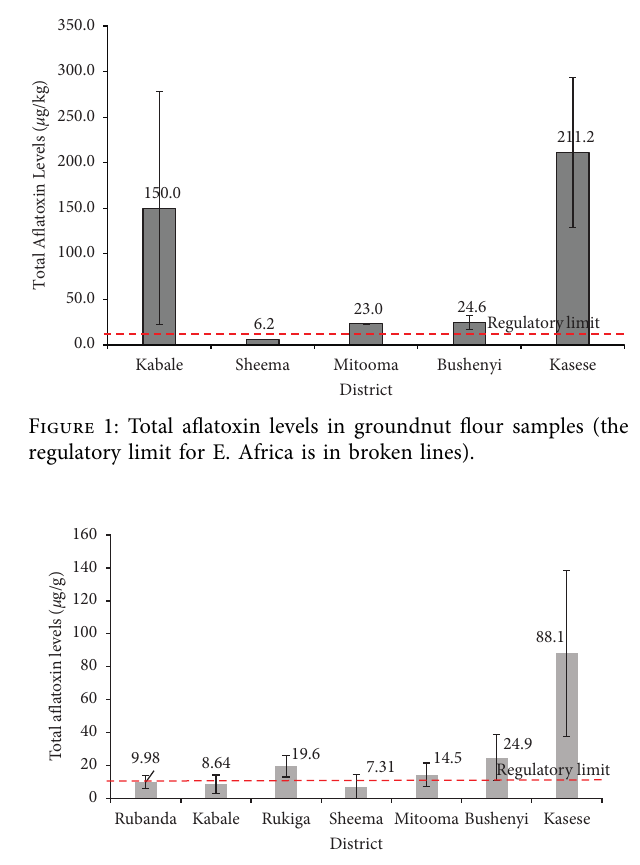
Figure 4: Total afatoxin levels in sorghum samples in selected districts of S.W. Uganda (the regulatory limit for E. Africa is in broken